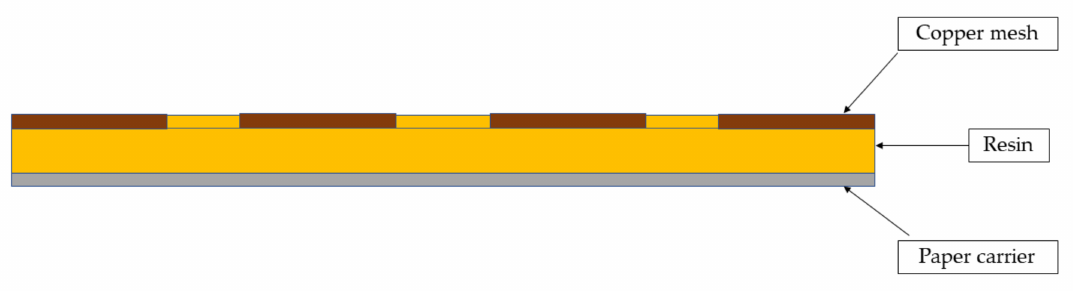
Figure 2. Structure of a lightning strike surfacing